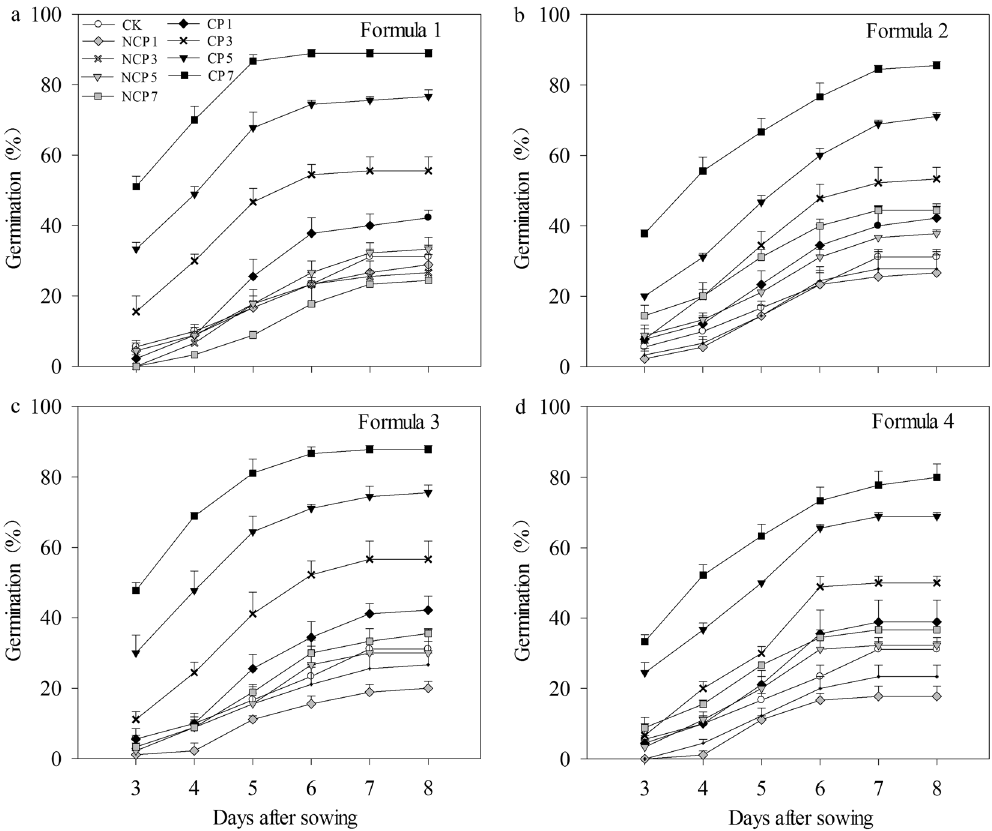
Figure 1. Germination dynamics of pelleted seeds in different formulae with various pelleting times and CaO 2 contents under waterlogging conditions (1.5 cm water layer) in Experiment 1. ( a ) Formula 1. ( b ) Formula 2. ( c ) Formula 3. ( d ) Formula 4. CK: naked seeds. CP: Calcium peroxide. CP1: Seeds were pelleted by pelleting agents with 10% of CaO 2 at a pelleting time of 1. CP3: Seeds were pelleted by pelleting agents with 10% of CaO 2 at a pelleting time of 3. CP5: Seeds were pelleted by pelleting agents with 10% of CaO 2 at a pelleting time of 5. CP7: Seeds were pelleted by pelleting agents with 10% of CaO 2 at a pelleting time of 7. NCP1: Seeds were pelleted by pelleting agents without 10% of CaO 2 at a pelleting time of 1. NCP3: Seeds were pelleted by pelleting agents without 10% of CaO 2 at a pelleting time of 3. NCP5: Seeds were pelleted by pelleting agents without 10% of CaO 2 at a pelleting time of 5. NCP7: Seeds were pelleted by pelleting agents without 10% of CaO 2 at a pelleting time of 7. Seed germination data were recorded from 3 DAS until constant at 8 DAS. Error bars indicate standard error (n =